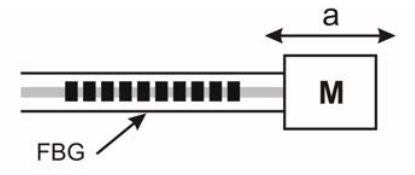
Figure 2. Diagram of a simple FBG